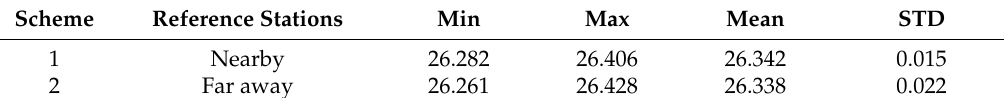
Figure 4. Apparent distance (as a function of time) between two kinematic antennas KIN1 and KIN3 without applying distance constraints; the trajectories of these antennas were estimated by using two reference stations 0801 and 0775 (Scheme 1). Table 2. The statistical results for the distance between KIN1 and KIN3 (Unit: m). Scheme